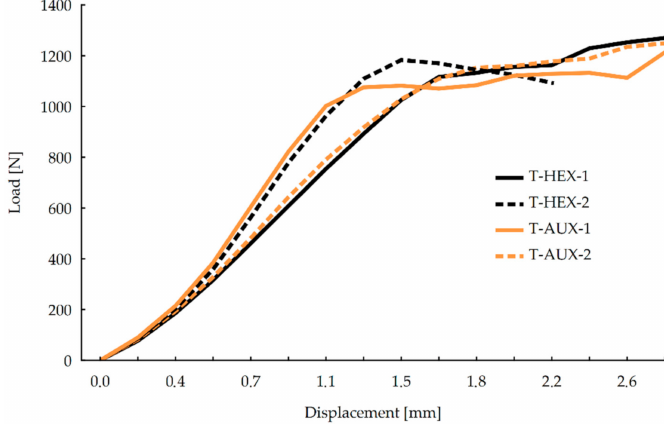
Figure 7. Sti ff ness of joints in the tension